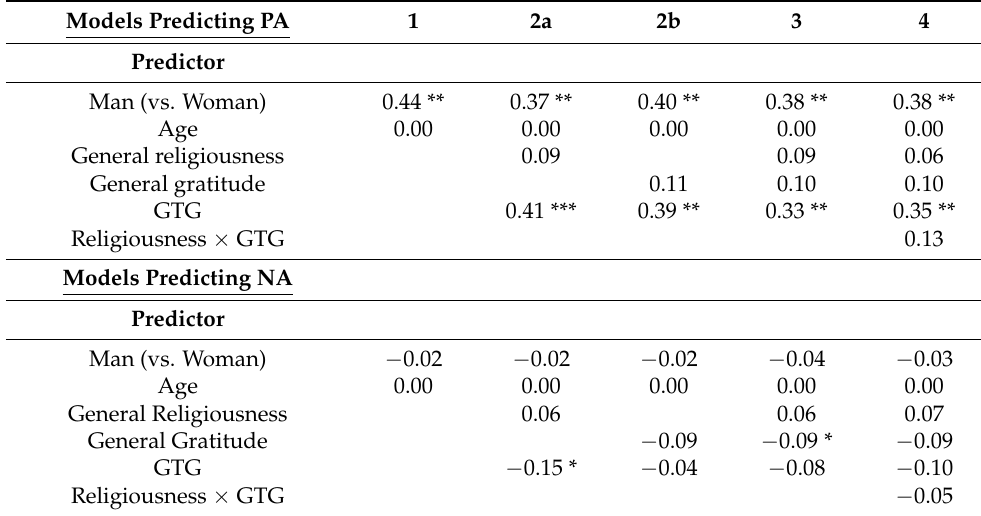
Table 6. Results from Regressions Predicting Positive Affect and Negative Affect. Models Predicting